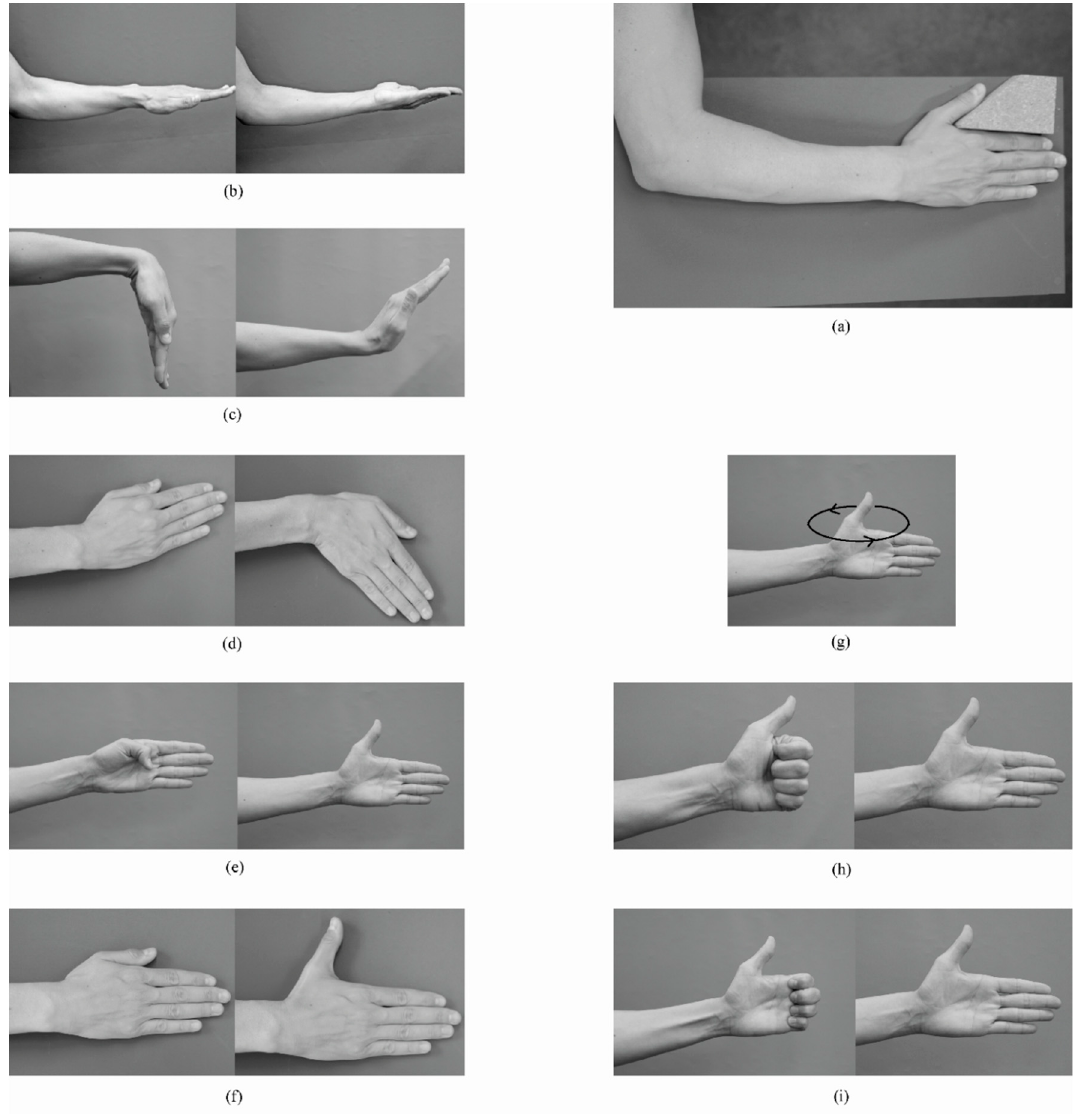
Figure 2. Illustration of the movements for the estimation of the functional wrist and thumb joint centers and axes and the maximum range of motion: ( a ) static reference position; ( b ) forearm pronation-supination; ( c ) wrist flexion-extension; ( d ) wrist radial-ulnar deviation; ( e ) thumb flexion-extension (involving IP, MCP and TMC joints); ( f ) thumb adduction-abduction; ( g ) thumb circumduction; ( h ) full finger flexion-extension; ( i ) distal finger flexion-extension; (involving only PIP and DIP joints) ( b ), ( c ), ( e ), ( g ), ( h ), ( i ) were performed in a standing position without a table keeping the arm close to the body and the elbow flexed at 90°; ( a ), ( d ), ( f ) were performed seated with the hand and forearm placed flat on the table.